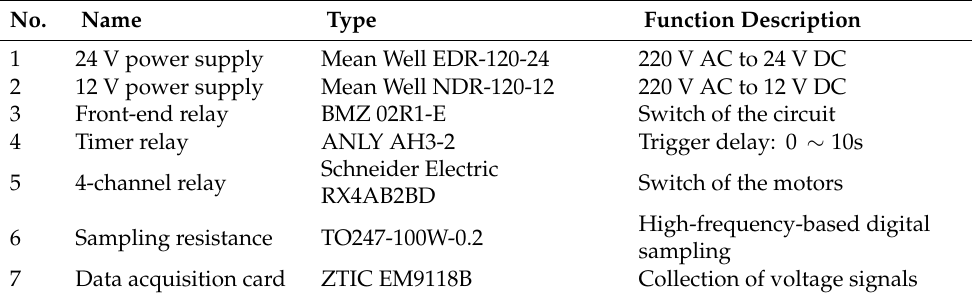
Figure 5. The fault diagnosis platform for PMDCMs. (1) 24 V power supply, (2) 12 V power supply, (3) Front-end relay, (4) Timer relay, (5) 4-channel relay, (6) Sampling resistance, (7) Data acquisition card. Table 2. Type and function description of the control cabinet